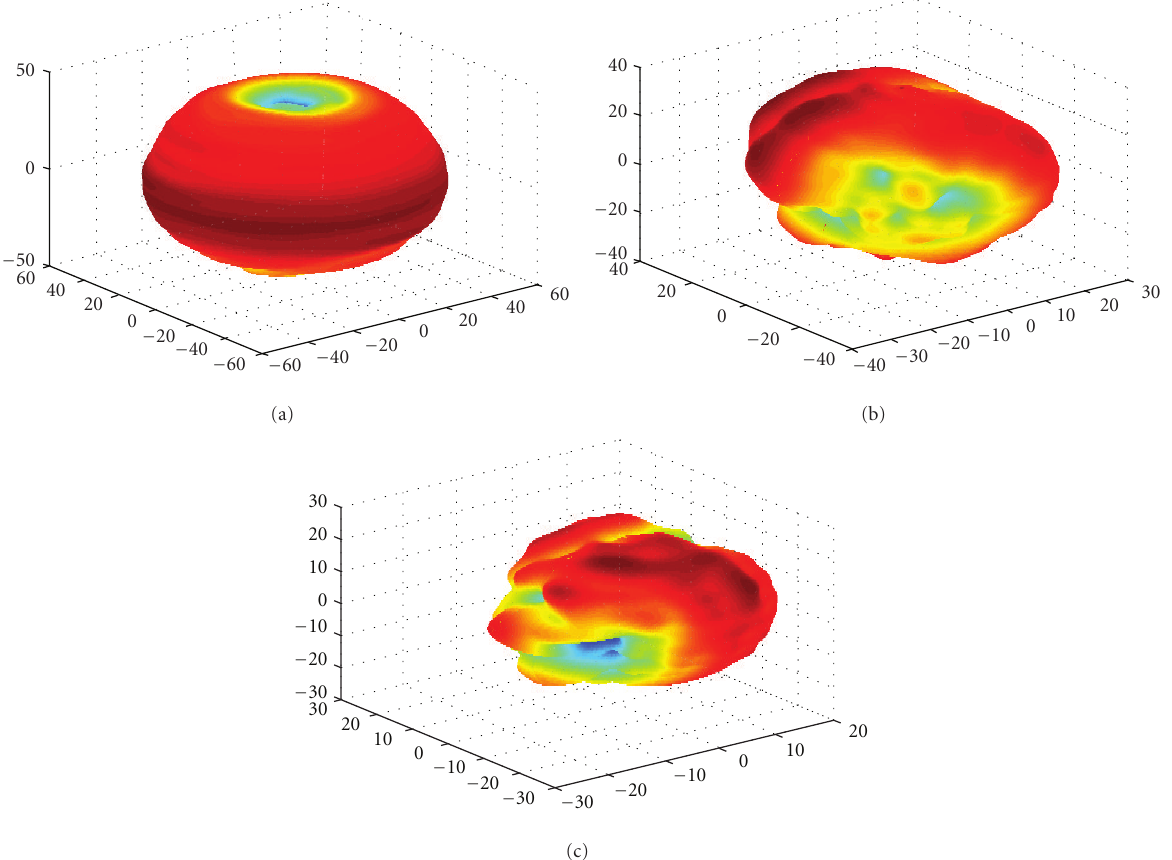
Figure 1: Measured far field radiation patterns for (a) dipole antenna; (b) PIFA antenna port 1; (c) PIFA antenna port